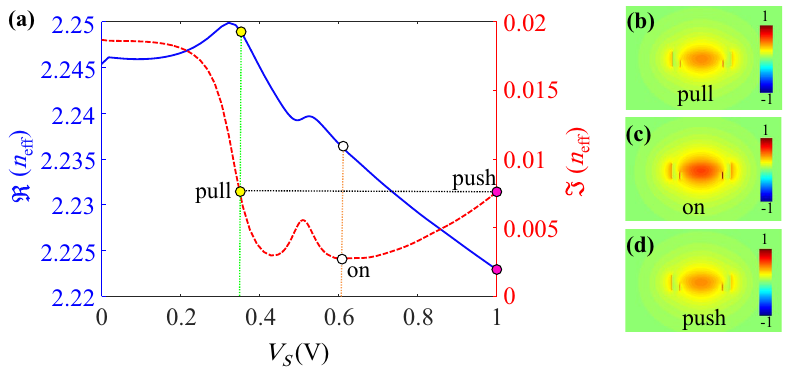
3.25 10 20 cm − 3 and as functions of the = ×